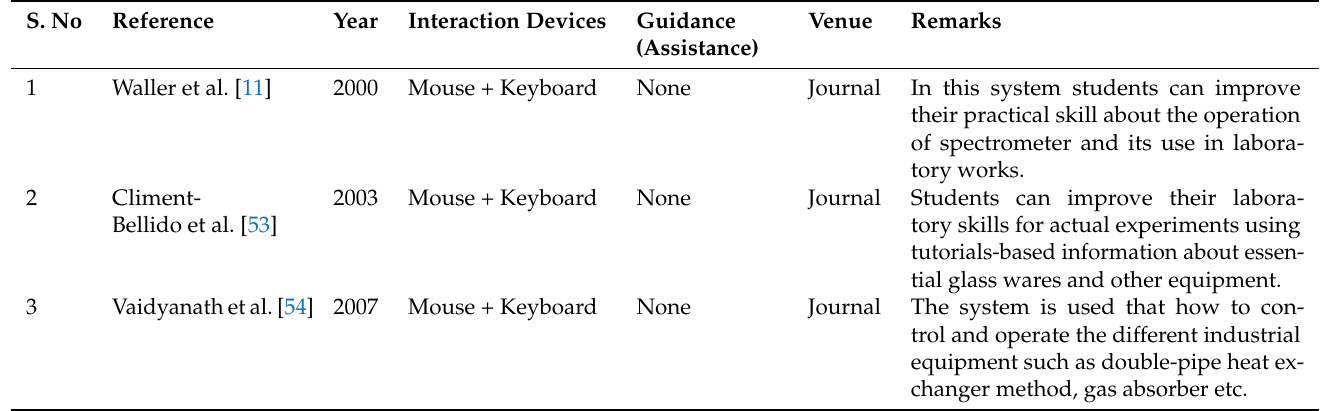
Table 1. Analysis of the existing Interactive Chemistry Laboratories in